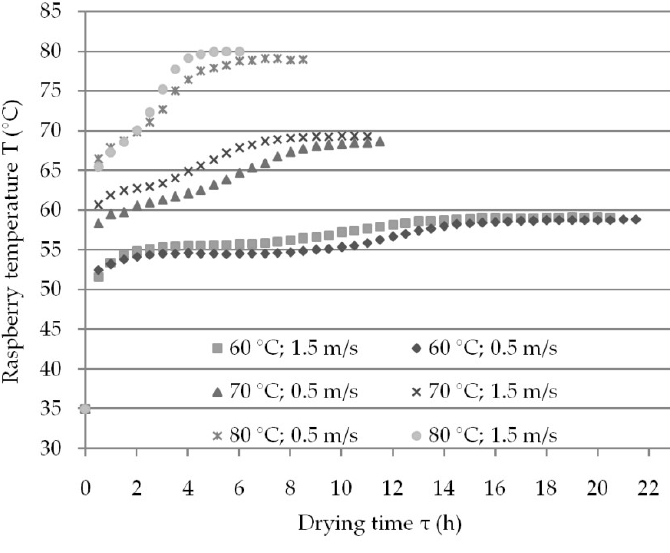
Figure 4. Raspberry temperature kinetics during convective drying from a previously fresh state.